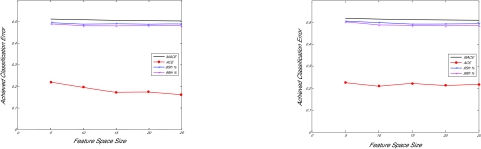
PACE analysis using a SVM-based classifier using the t-test scoring criterion, with a 0.6 MAC threshold. Left Panel: performance without peak selection. Right panel: performance with peak selection.